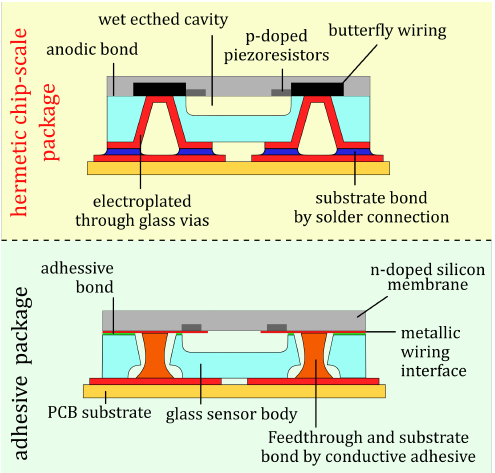
Figure 2. Schematic cross-sections of the hermetic CSP ( top ) in comparison with the earlier adhesive package sensor concept [6–8] ( bottom ).